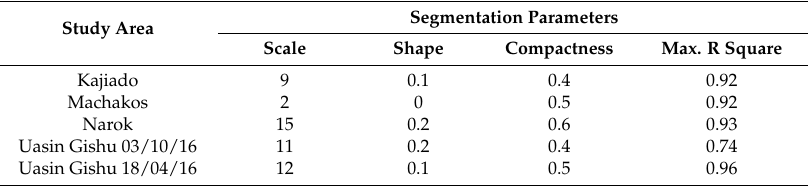
Figure 4. Demonstration of the R Square for each segmentation configuration (scale, shape, and compactness parameters) for the Machakos scene. Table 3. Selected configuration for each scene with the corresponding R